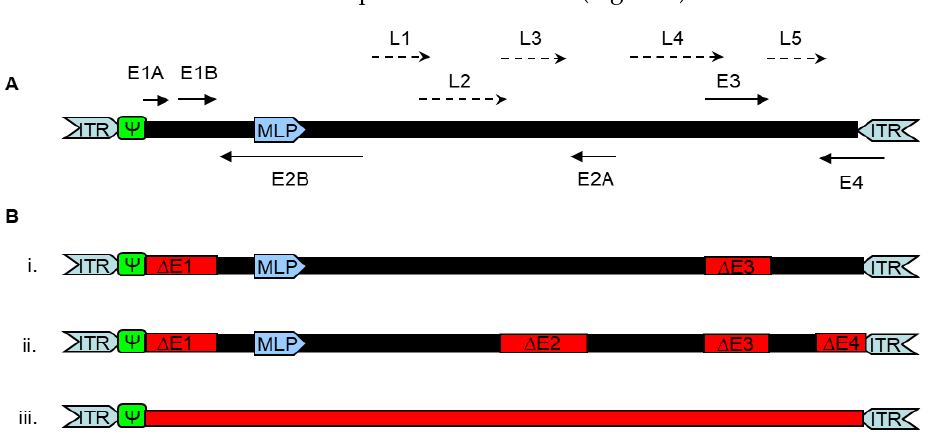
Figure 1. Schematic overview over the wild-type adenovirus and recombinant adenoviral vector genomes. ( A ) Map of the wild-type adenovirus genome and its transcription units. The central, solid line represents (black) the viral genome. Positions of the left and right inverted terminal repeats (ITRs, grey), the packaging signal (Ψ, green), the early transcription units (E1A, E1B, E2A, E2B, E3, and E4 in solid arrow), and the late transcription units (major late promoter (MLP), blue; L1–L5 in dashed arrow) are shown. Arrows indicate the direction of transcription. ( B ) Different generations of recombinant adenoviral vectors used in gene therapy. Elements shown in red represent deletions providing space for insertion of transgene cassette. i. First-generation adenoviral vectors lacking E1 and/or E3. ii. Second-generation adenoviral vectors with multi-deletions. iii. High-capacity adenoviral vectors (HCAdV) with all viral coding regions deleted.